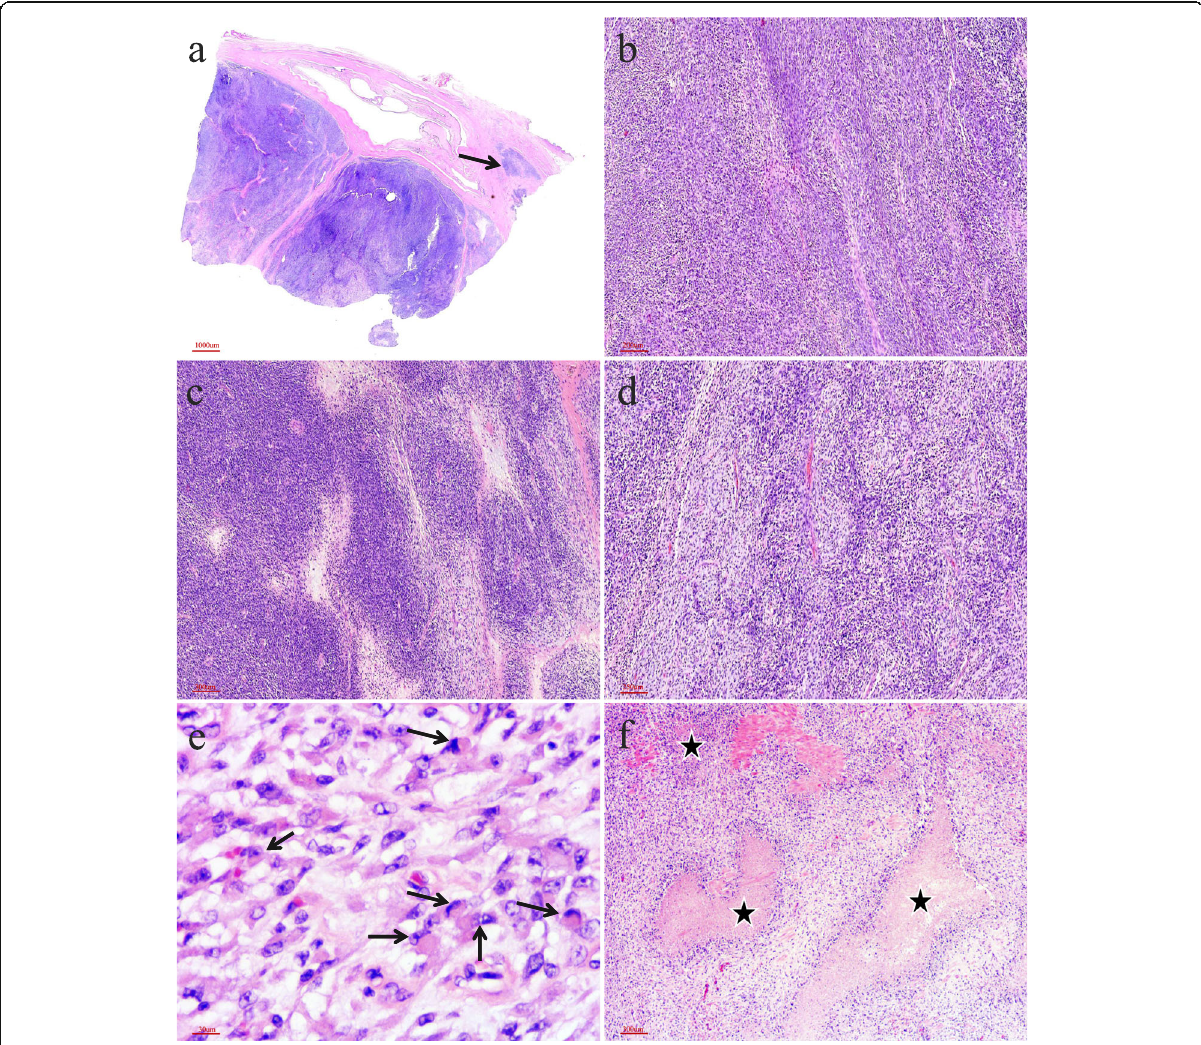
Fig. 3 Histologic characteristics of ARID1A deficient undifferentiated spindle cell and rhabdoid sarcoma of the prostate. ( a ) Lower magnification showing a densely cellular, solid and lobulated tumor with an overall pushed but multifocal infiltrating border ( as indicated by arrow ). ( b, c ) The tumor cells were mainly mildly atypical, oval to spindle-shaped cells, arranging in sheets and fascicles or herringbone-like patterns within edematous to myxoid, vascularized stroma. ( d ) Areas of storiform, whirling or morular structures are noted. ( e ) Groups of discohesive rhabdoid tumor cells ( as indicated by arrows ) and ( f ) multifocal geographic necroses ( as indicated by asterisks ) are